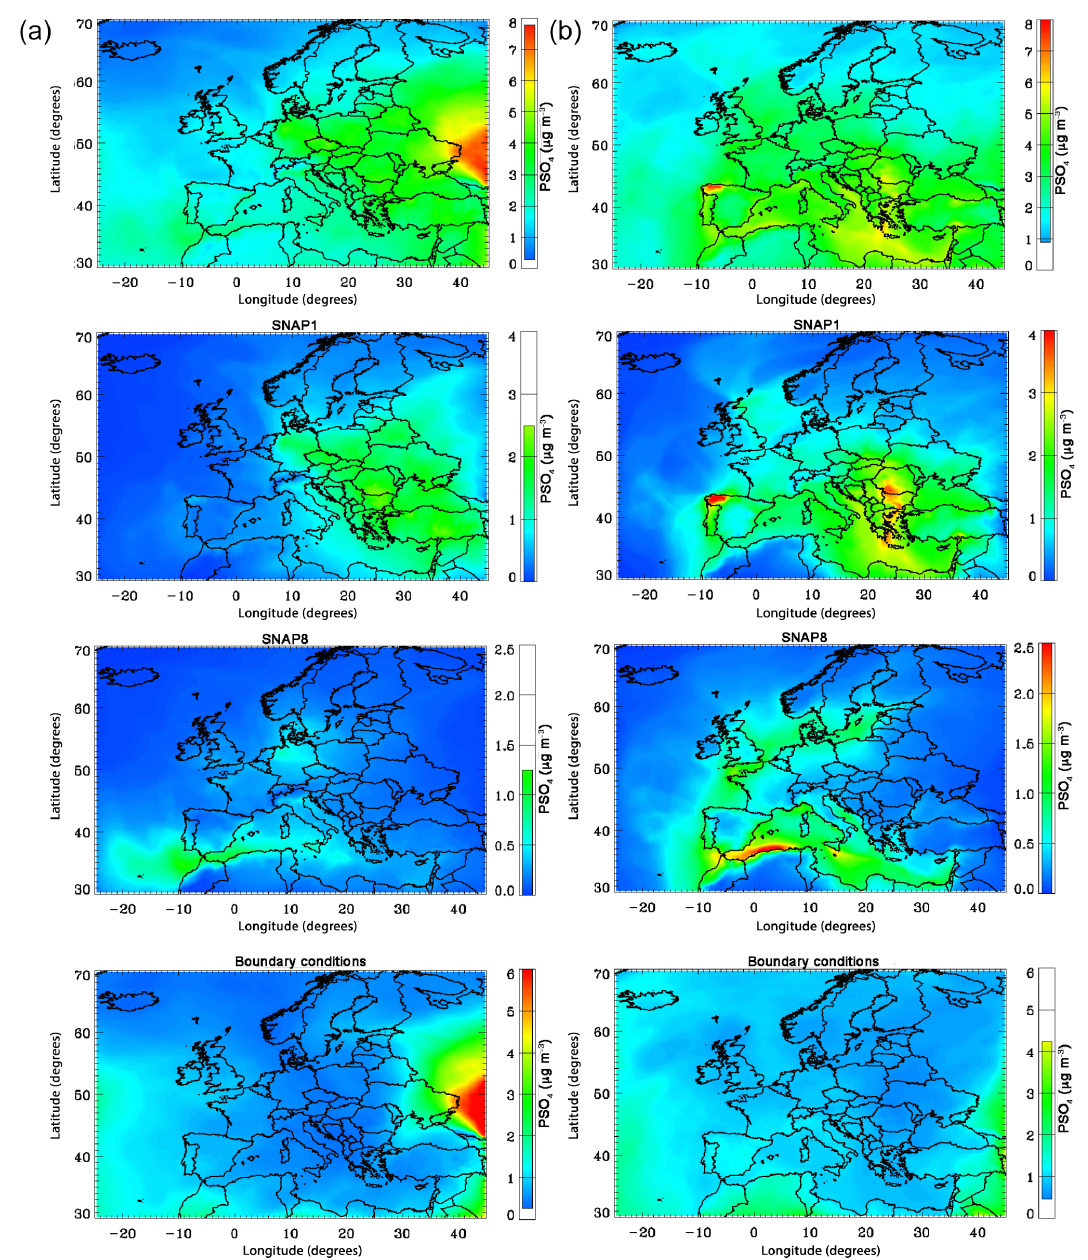
Figure 3. Average concentrations of PSO 4 (top panels) and contributions from combustion in energy and transformation industries (SNAP1), ships (SNAP8) and boundary conditions in February–March 2009 (a) and in June 2006 (b)